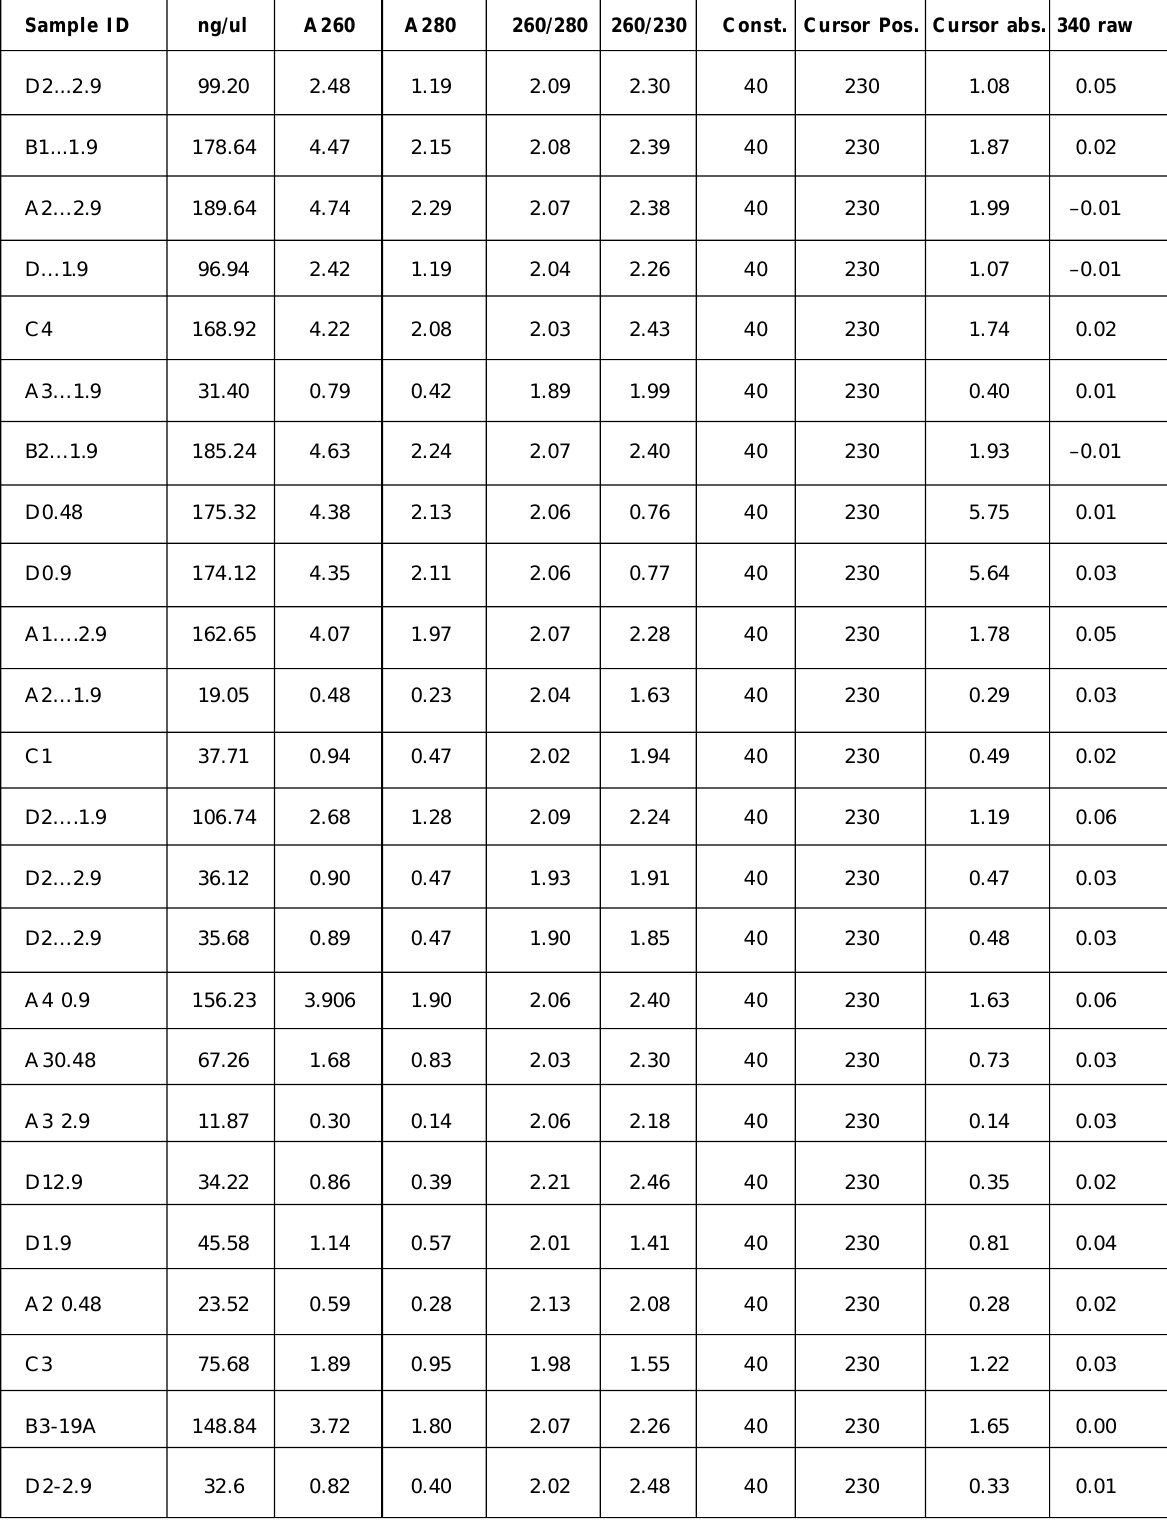
Table 2: RNA concentration measured by spectrophotometer for each of the samples extracted Sample